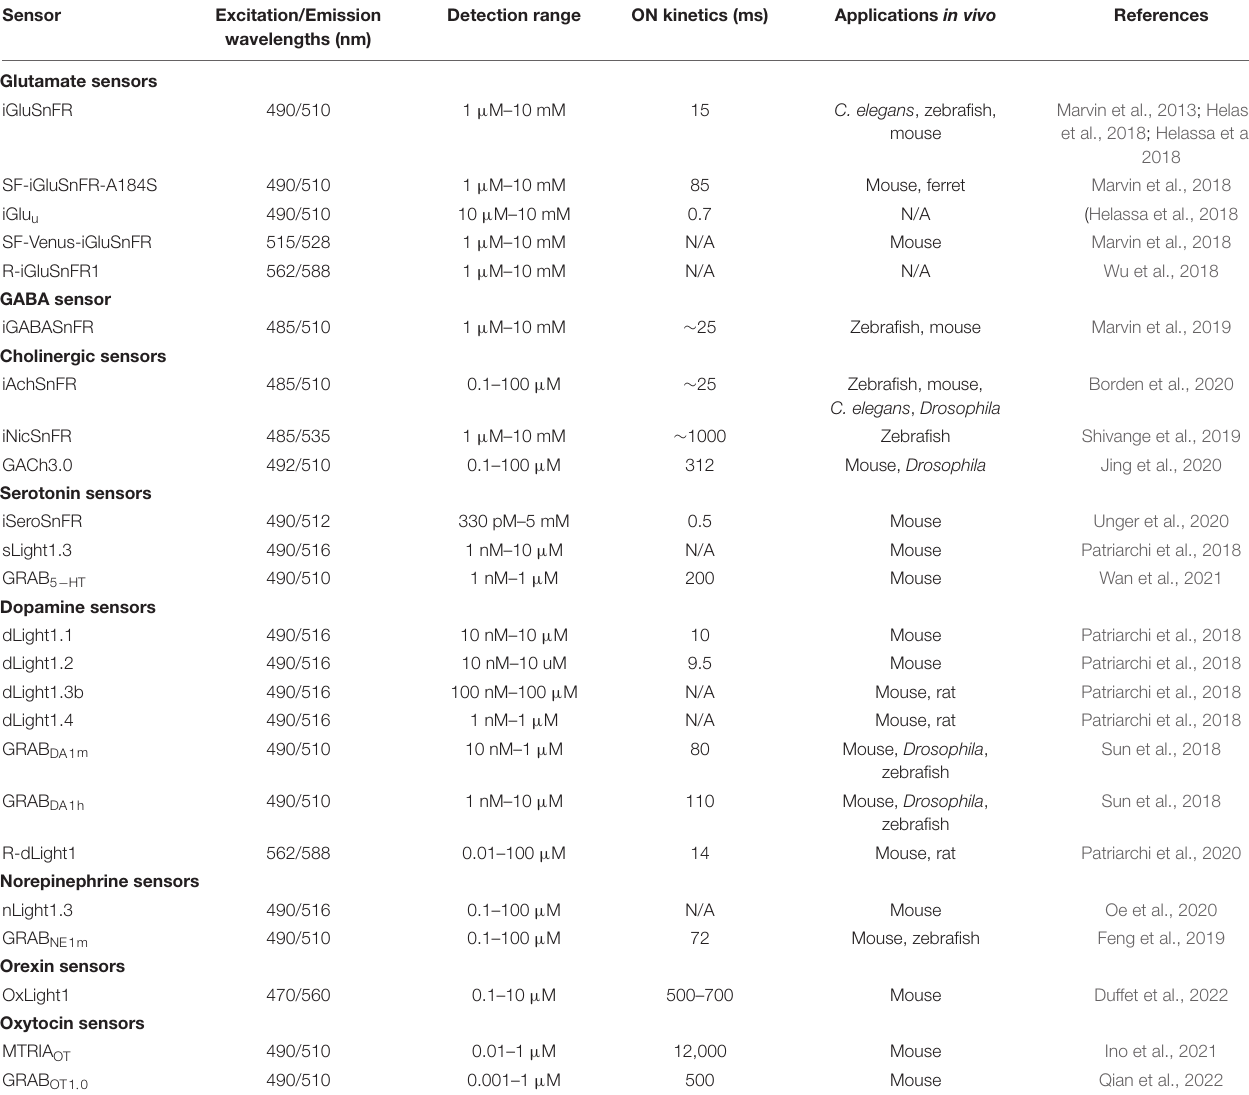
TABLE 5 | Properties and applications of genetically encoded neurotransmitter